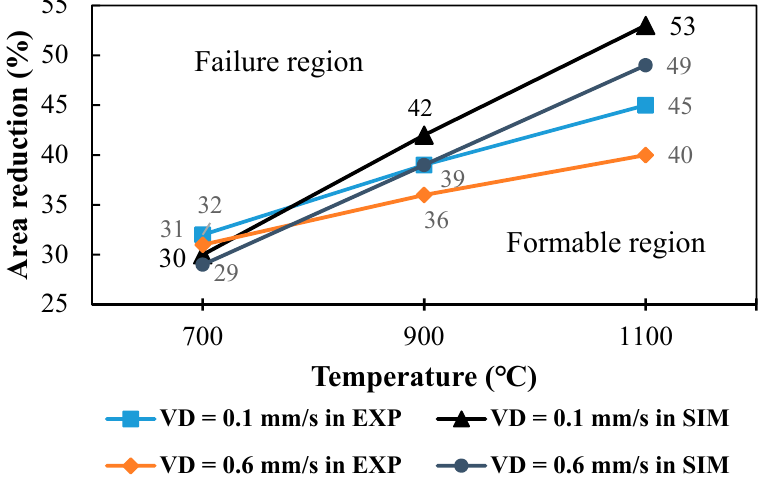
Figure 15. Comparisons of maximal reachable area reduction between simulations and experiments.